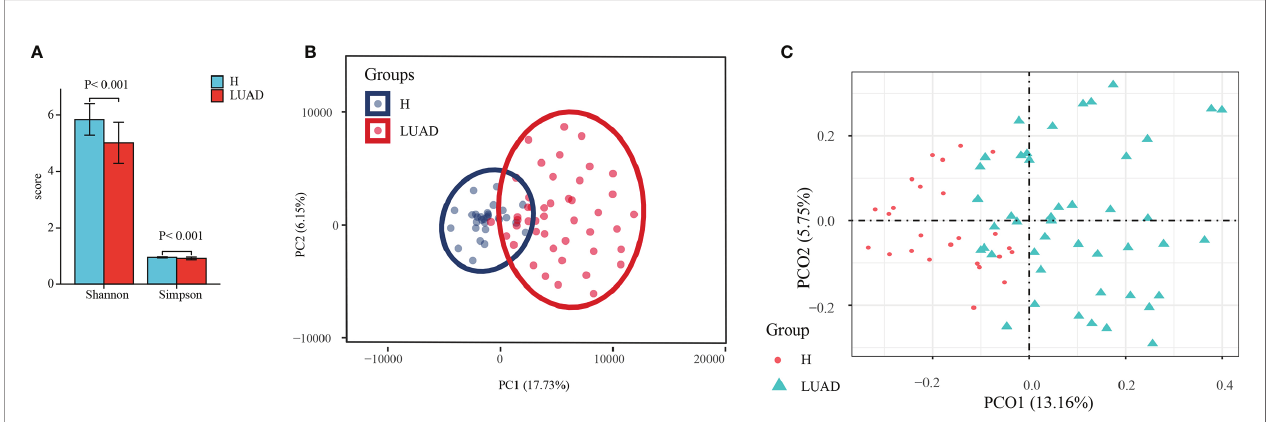
FIGURE 1 | The assessment of the a and b diversity. (A) The a diversity was evaluated by Shannon and Simpson index. (B) The b diversity was evaluated by PCA analysis. (C) The b diversity was evaluated by PCoA analysis. H, healthy individuals; LUAD, Lung adenocarcinoma; PCA, Principal Component Analysis; PCoA, Principal coordinate